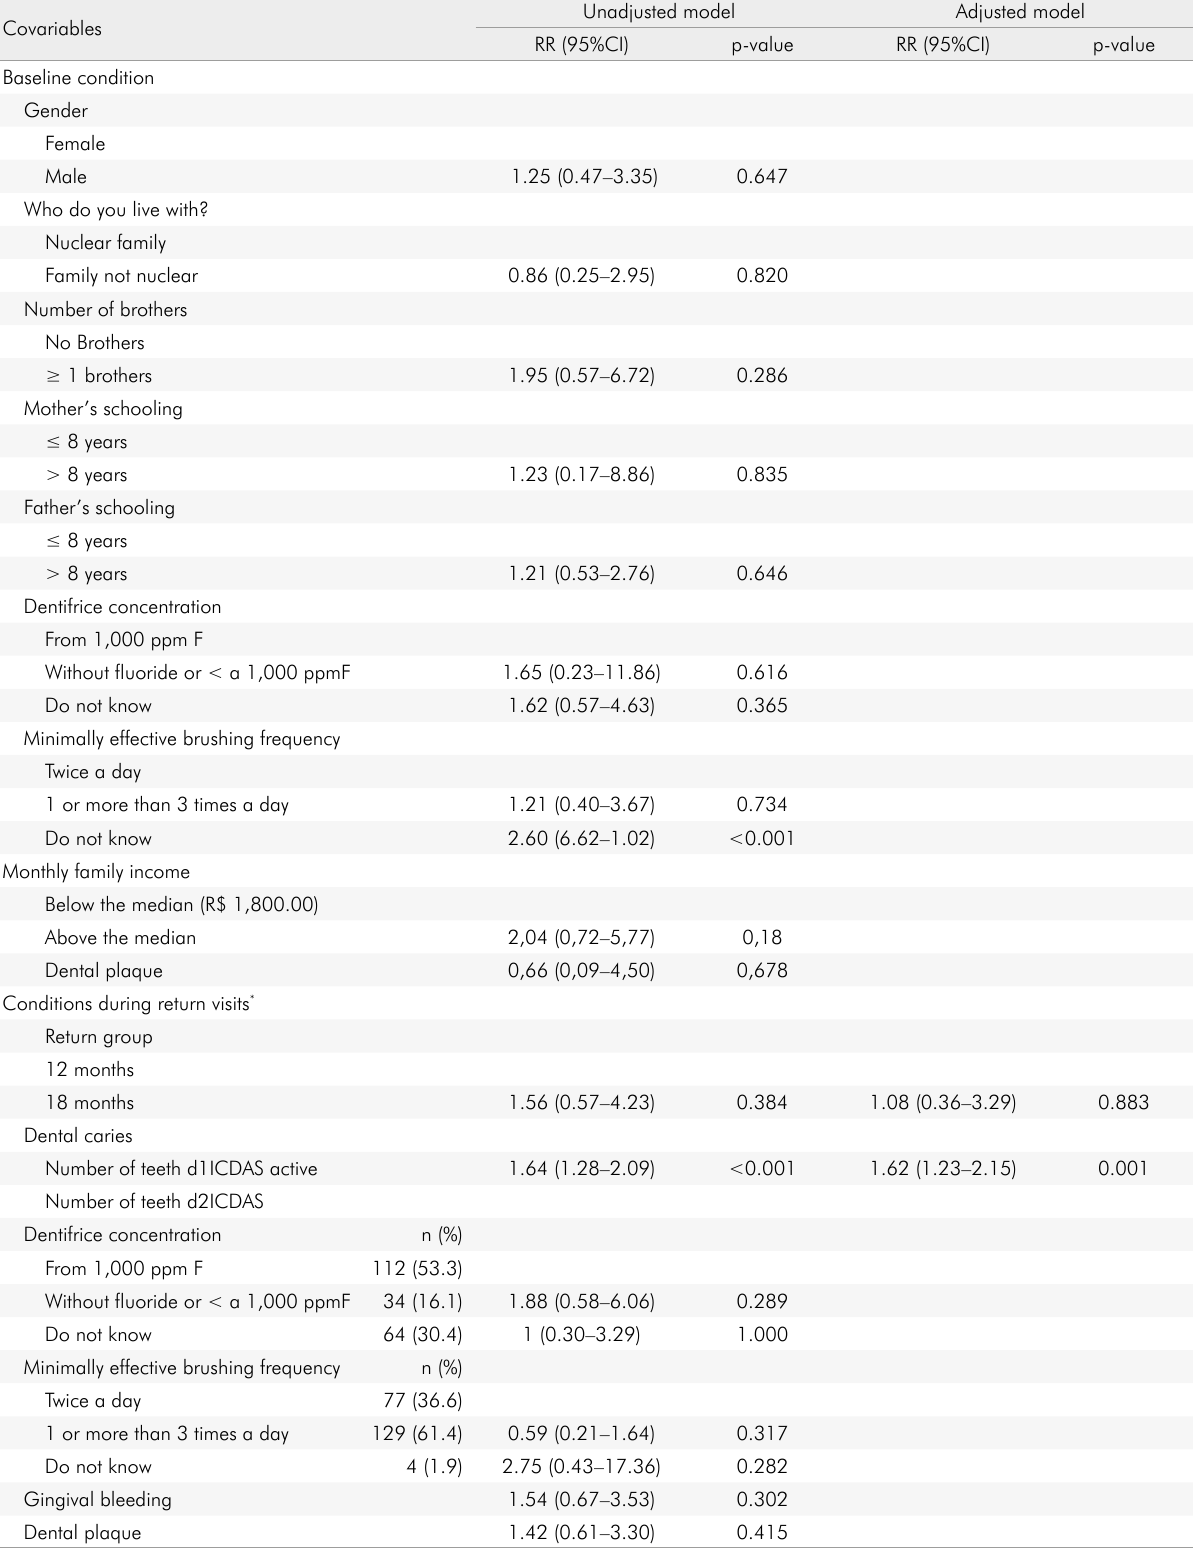
Table 5. Adjusted and unadjusted Poisson Regression analysis of the variables associated with the incidence of new active cavitated dentin caries (d3ICDAS) (n =